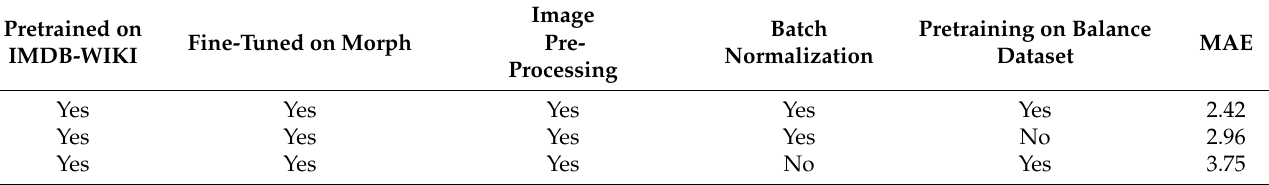
Table 6. The insights of the real age estimation